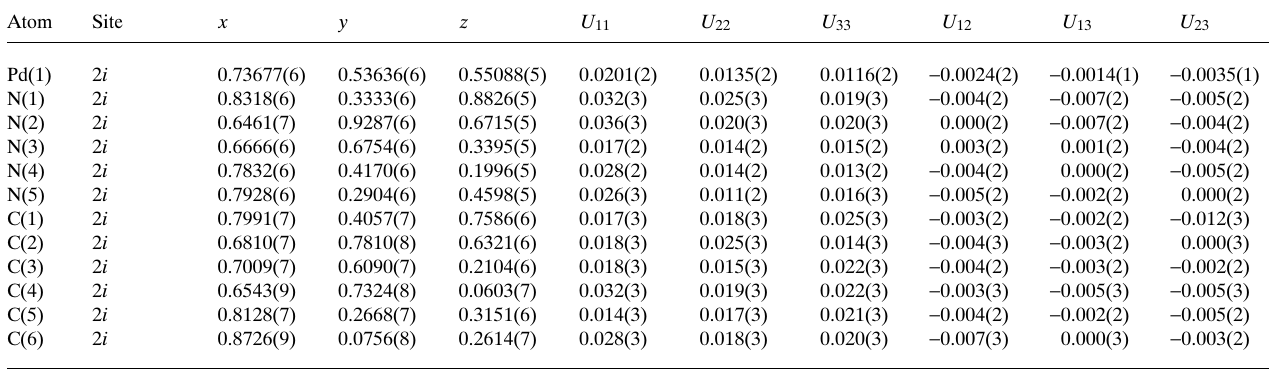
Table 3. Atomic coordinates and displacement parameters (in Å 2 ) .